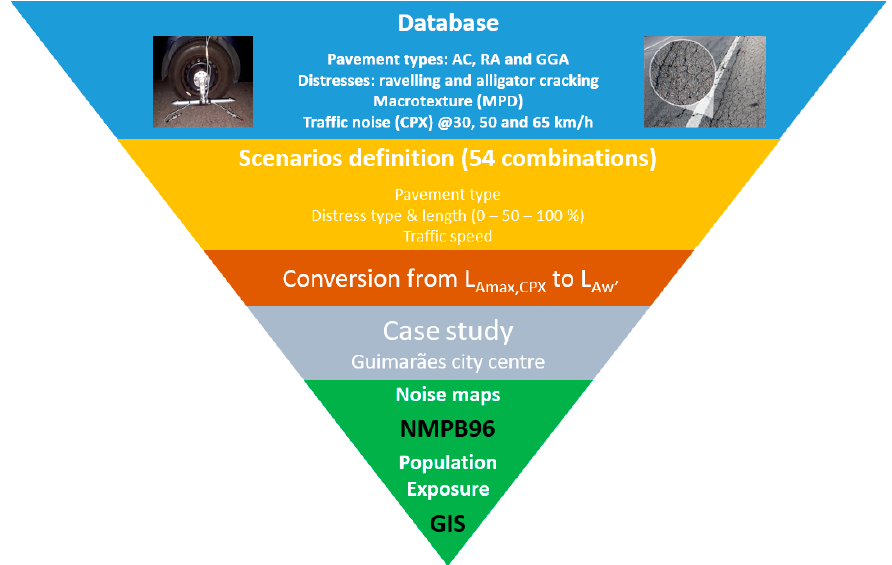
Figure 1. Study methodology. AC: asphalt concrete; RA: rubber asphalt; GGA: gap-graded asphalt; GIS: Geographical Information System.